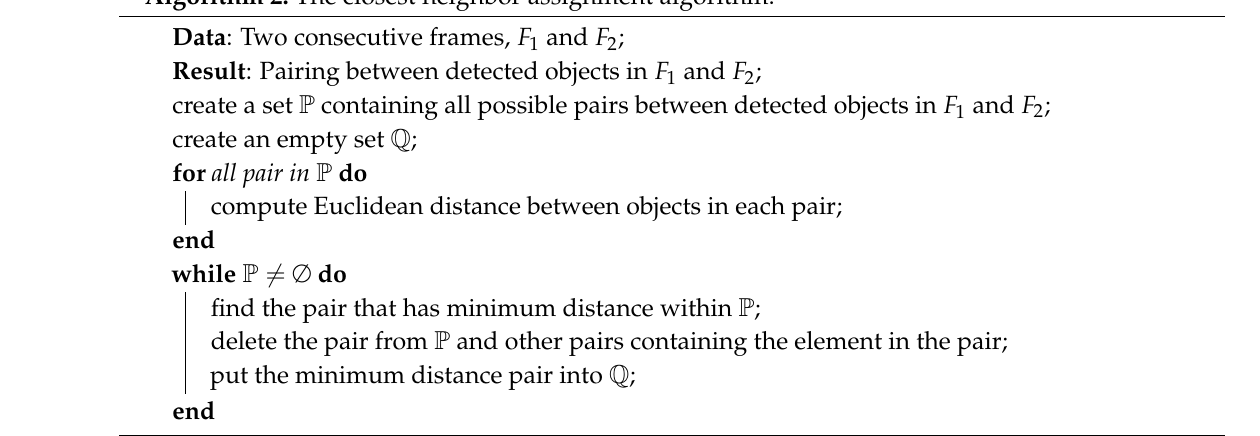
Algorithm 2: The closest neighbor assignment